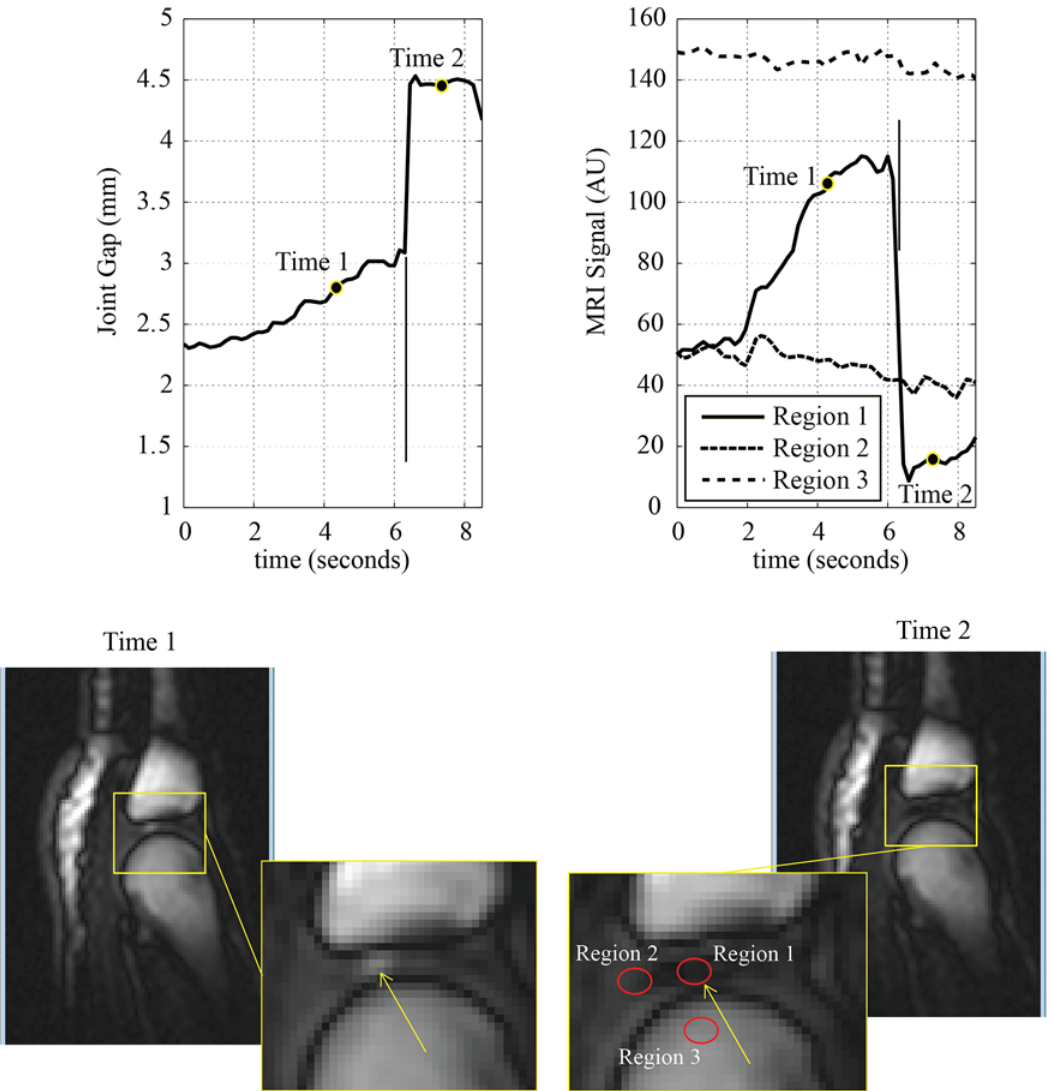
Fig 4. Time series plots for joint separation distance and signal intensity over the course of a representative MCP joint cracking (plots). Cine MRI images displayed are those immediately prior to, and after, joint cracking with zoomed regions to demonstrate areas where signal intensities were measured for the region of interest as well as control